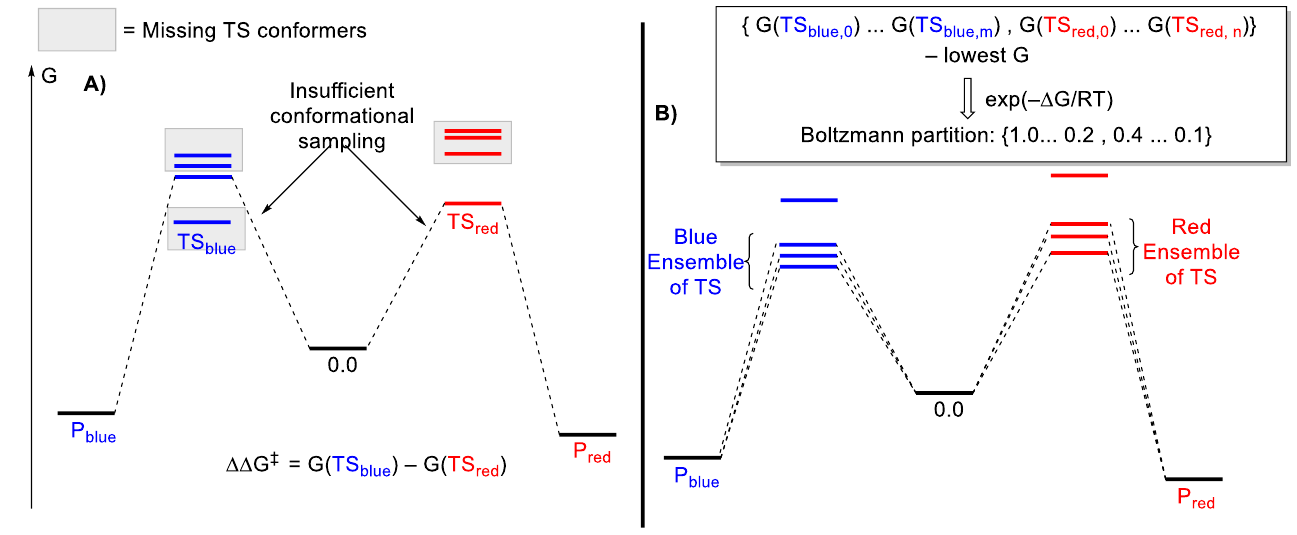
Figure 4. Hypothetical scenario ( A ) The lowest-lying TS blue conformer is omitted. The opposite selectivity is thus predicted. ( B ) Many conformers with significant populations at the reaction temperature and pressure. An ensemble is required to obtain a more accurate calculated value of selectivity.